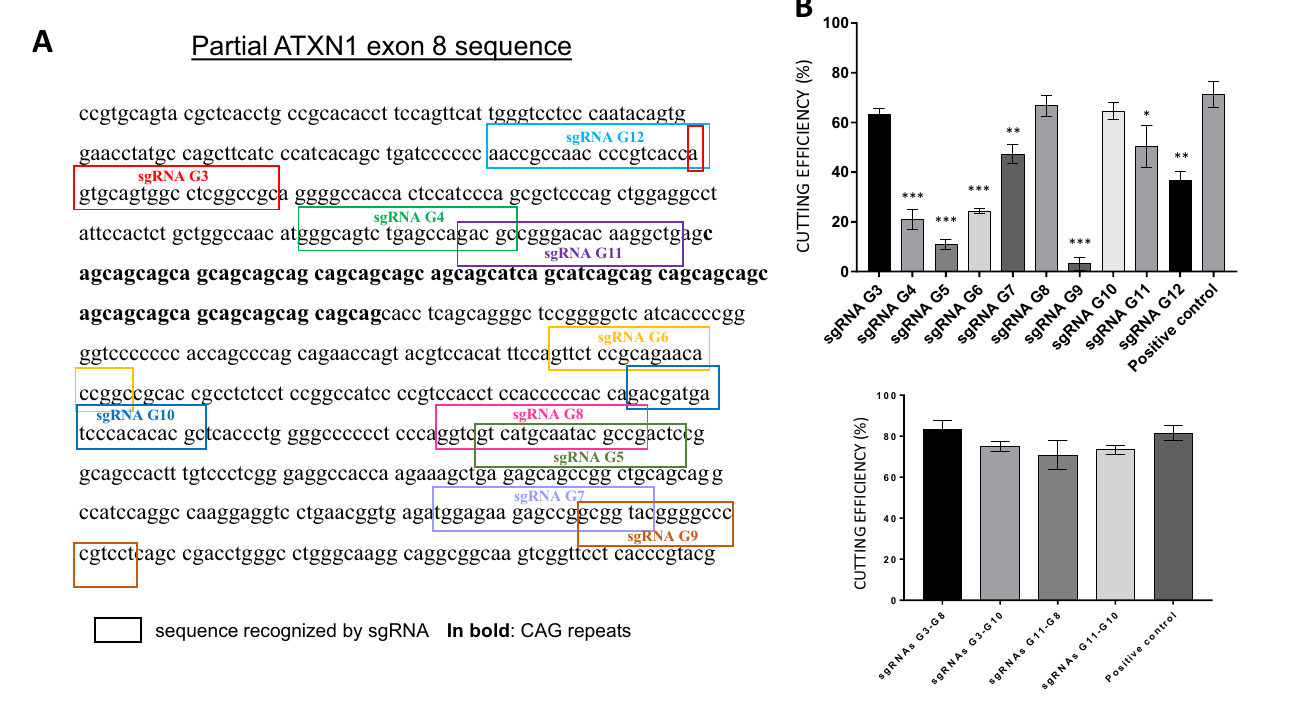
Figure 1. Design and in vitro screening of sgRNAs for ATXN1 gene. ( A ) sgRNAs were designed using the CRISPR design software by Zhang lab 19 . Ten sgRNAs capable of cutting upstream and downstream of the polyQ tract were identified. ( B ) In vitro screening tests were performed to evaluate the sgRNAs cutting efficiency, using Guide-it sgRNA In Vitro Transcription and Screening System (CLONTECH). ( C ) The most efficient sgRNAs were then tested in pairs. The positive control is supplied by the kit and is designed to achieve high efficiency DNA double helix cleavage. For this reason, it was used as a comparison for the relative quantification of the cleavage efficiency of the designed sgRNAs. Values are mean ± s.e.m. from three independent experiments. *p < 0,05; **p < 0,005; ***p < 0,001. Samples G3, G8 and G10 confirm the null hypothesis that there is no significant difference in cutting efficiency compared to the positive control provided by the